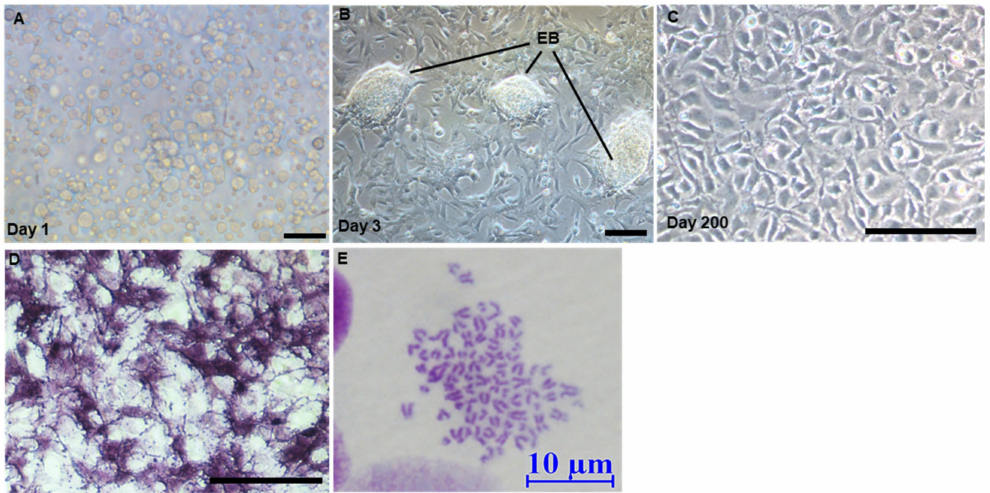
Figure 2. Derivation of ObSSCs. ( A ) Testicular cells after enzymatic dissociation. ( B ) O. bidens primary testis cells were cultured on the 3rd day. ( C ) Morphology of ObSSCs at Passage 78 and Day 200. ( D ) Alkaline phosphatase staining. EB, embryoid bodies. ( E ) Diploid metaphase of ObSSCs. (Bars = 100 µ m unless